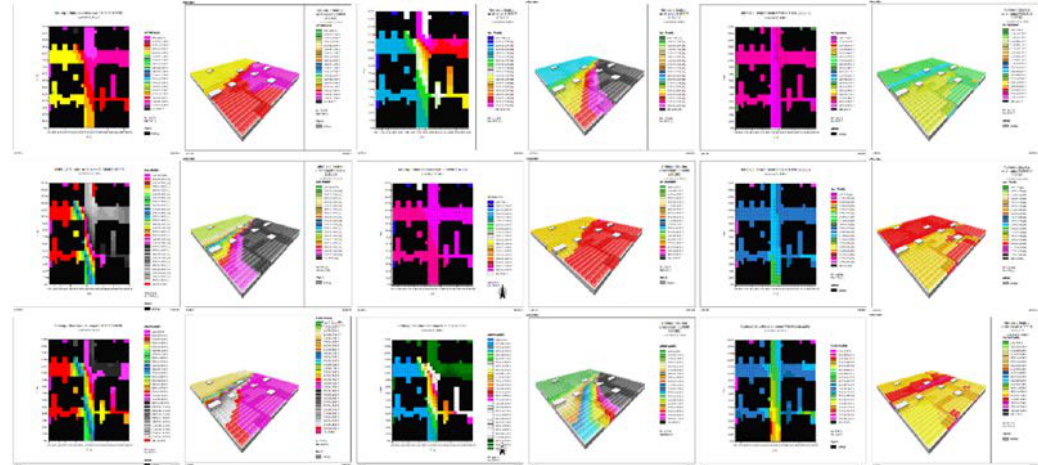
Fig. 6: 3D thermal model and map, specific humidity and relative humidity resulting from simulation of the hottest, coldest and sultry day of the year for compact building type .